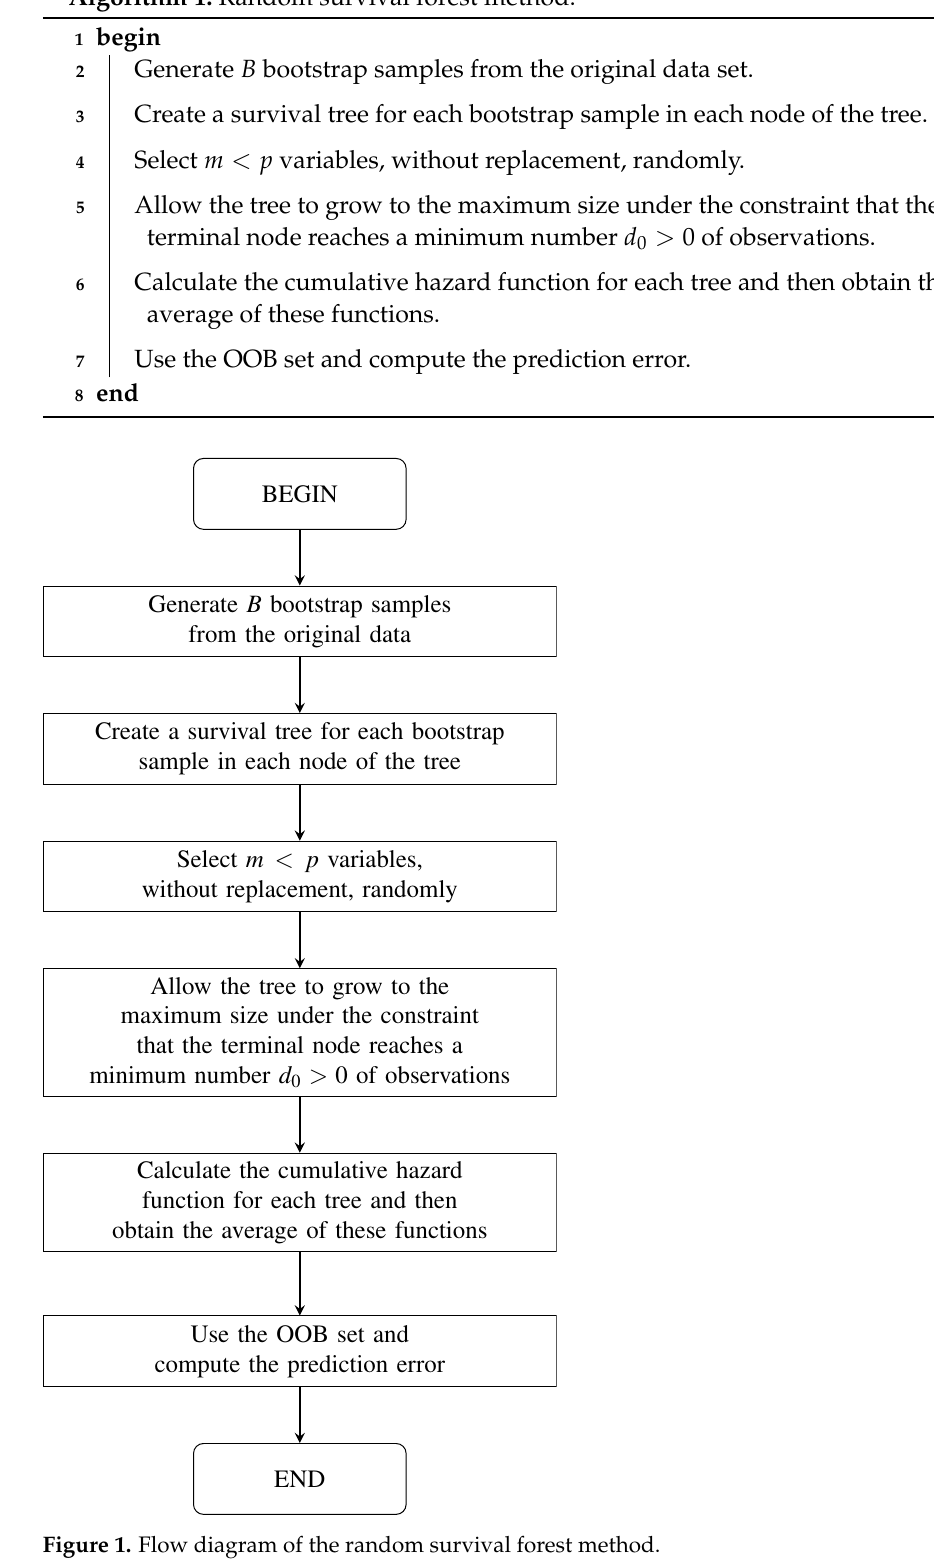
Algorithm 1: Random survival forest method.